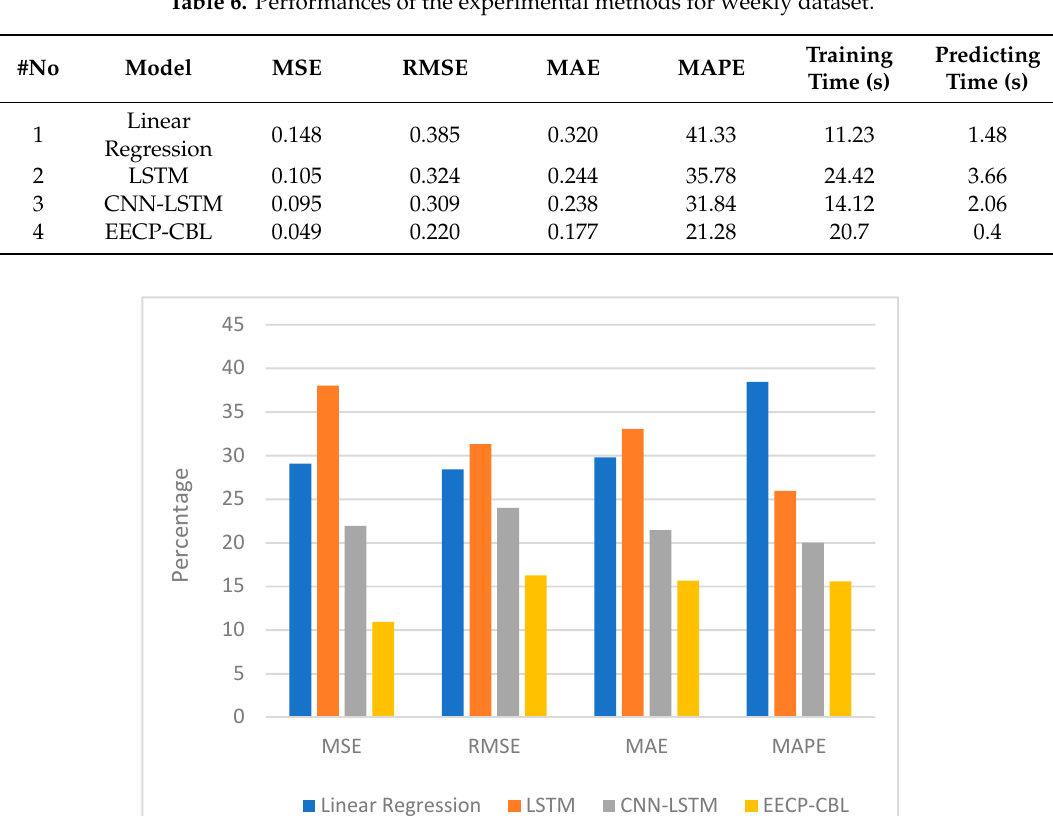
Table 6. Performances of the experimental methods for weekly dataset.